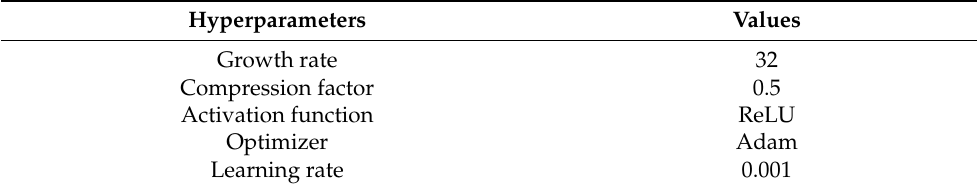
Table 3. Hyperparameter